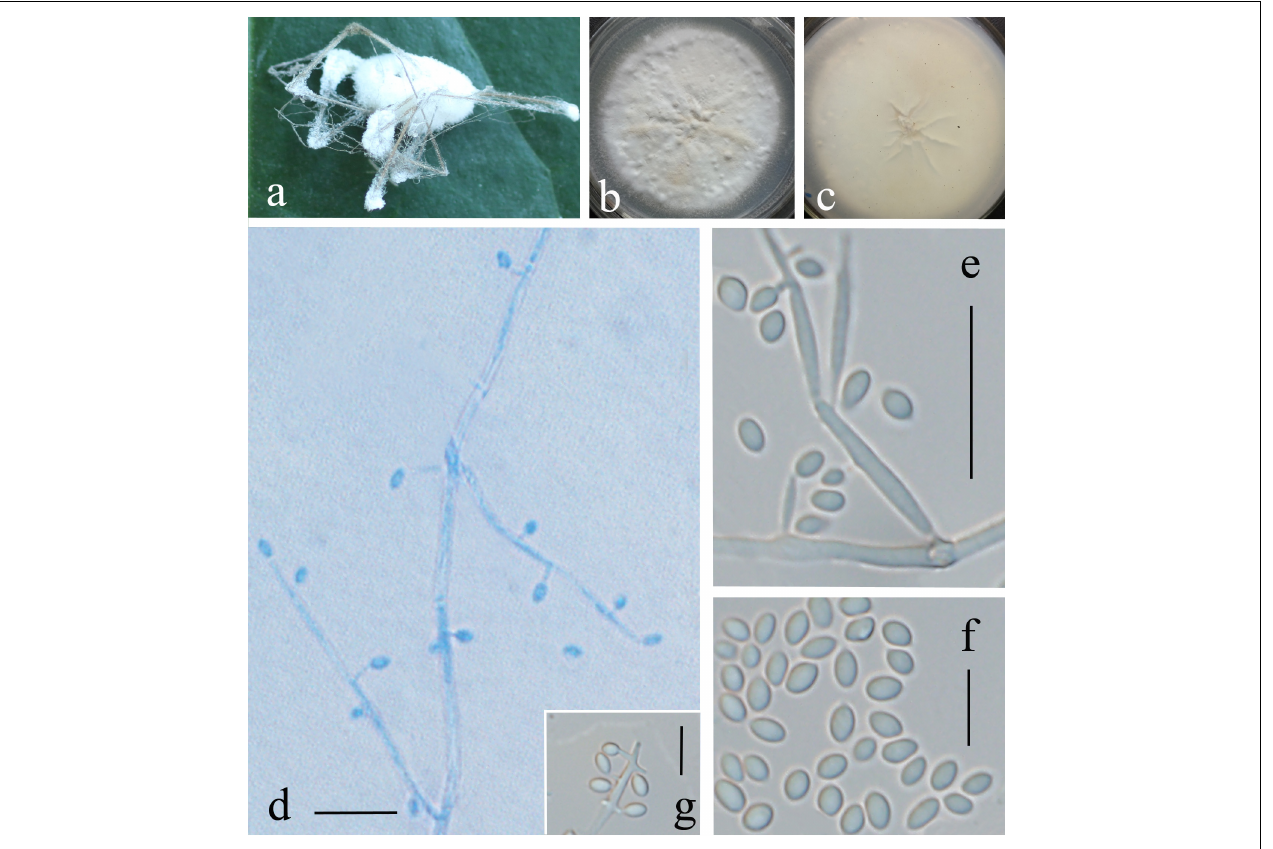
FIGURE 3 | Lecanicillium huhutii . (a) Synnemata emerged from the corpse of a spider. (b,c) Culture plate, cultured on PDA medium. (d–g) Conidiophores, conidiogenous cells, and conidia. Bars: (d,e) = 10 mm; (f,g) = 5 µ